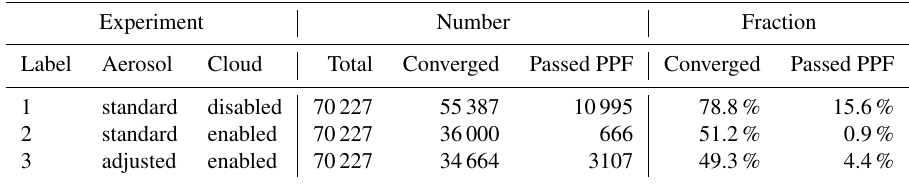
Table 7. Success rates for converged soundings and soundings that passed the PPF.